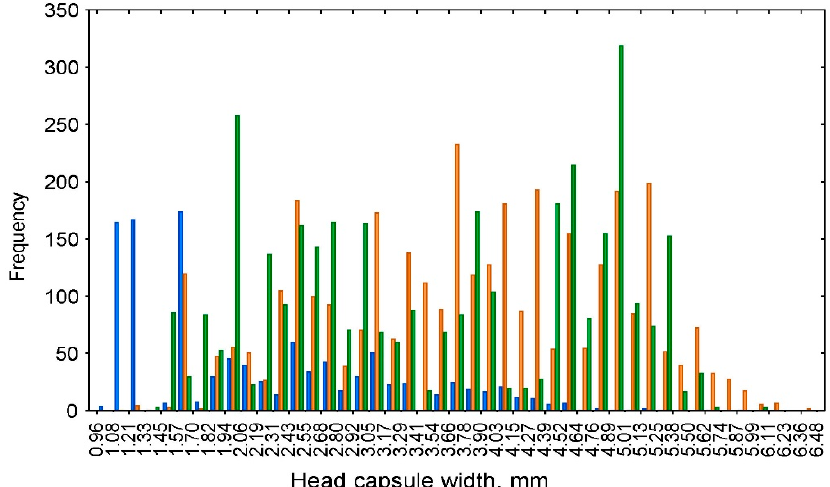
Figure 1. Frequency distribution of the head capsule widths for three groups of Dendrolimus pini larvae: lab (blue), field–lab (orange), and field (green).